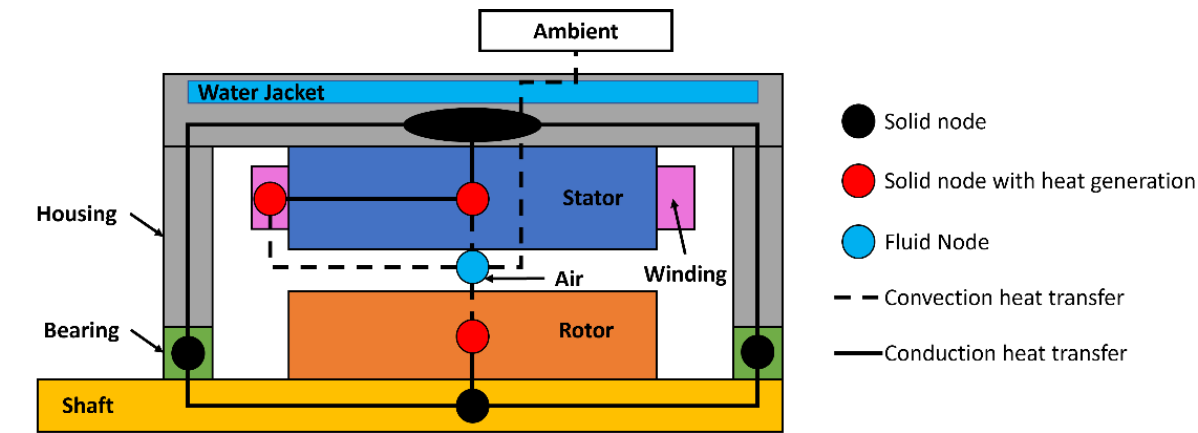
Figure 13. PMSM lumped thermal model.